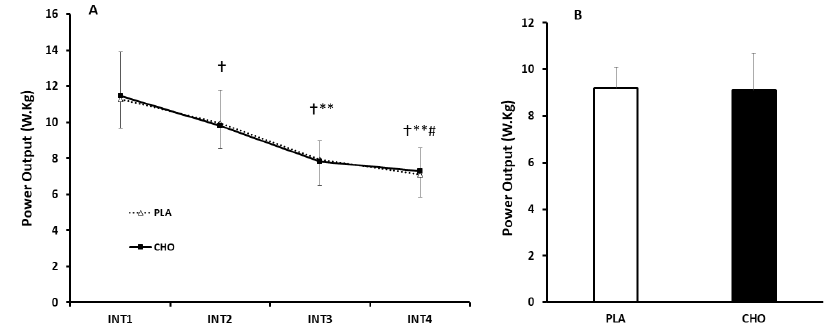
Figure 1. ( A ) Comparison of relative peak power output (RPPO) response between INT1–4 in acute